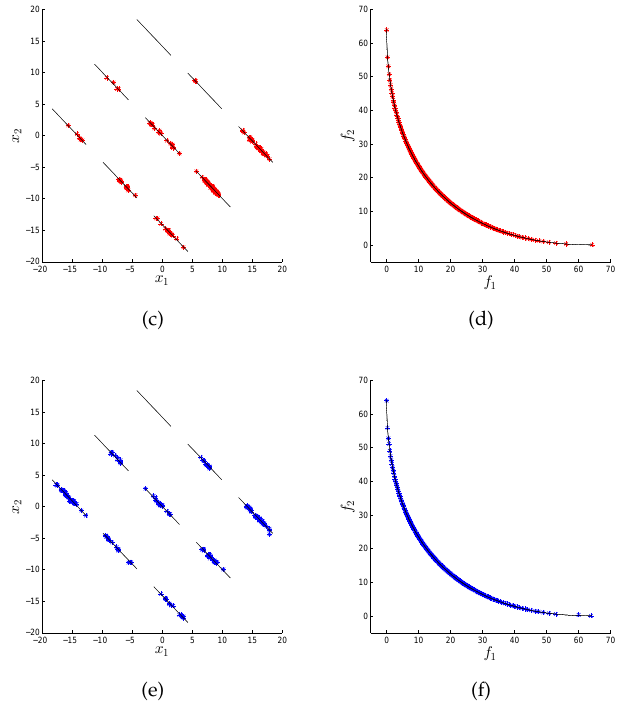
Figure 8. Graphical results of the run with the median values for the RPH2 function for the NSGA-III algorithm. ( a ) Decision Space Original; ( b ) Objective Space Original; ( c ) Decision Space VR; ( d ) Objective Space